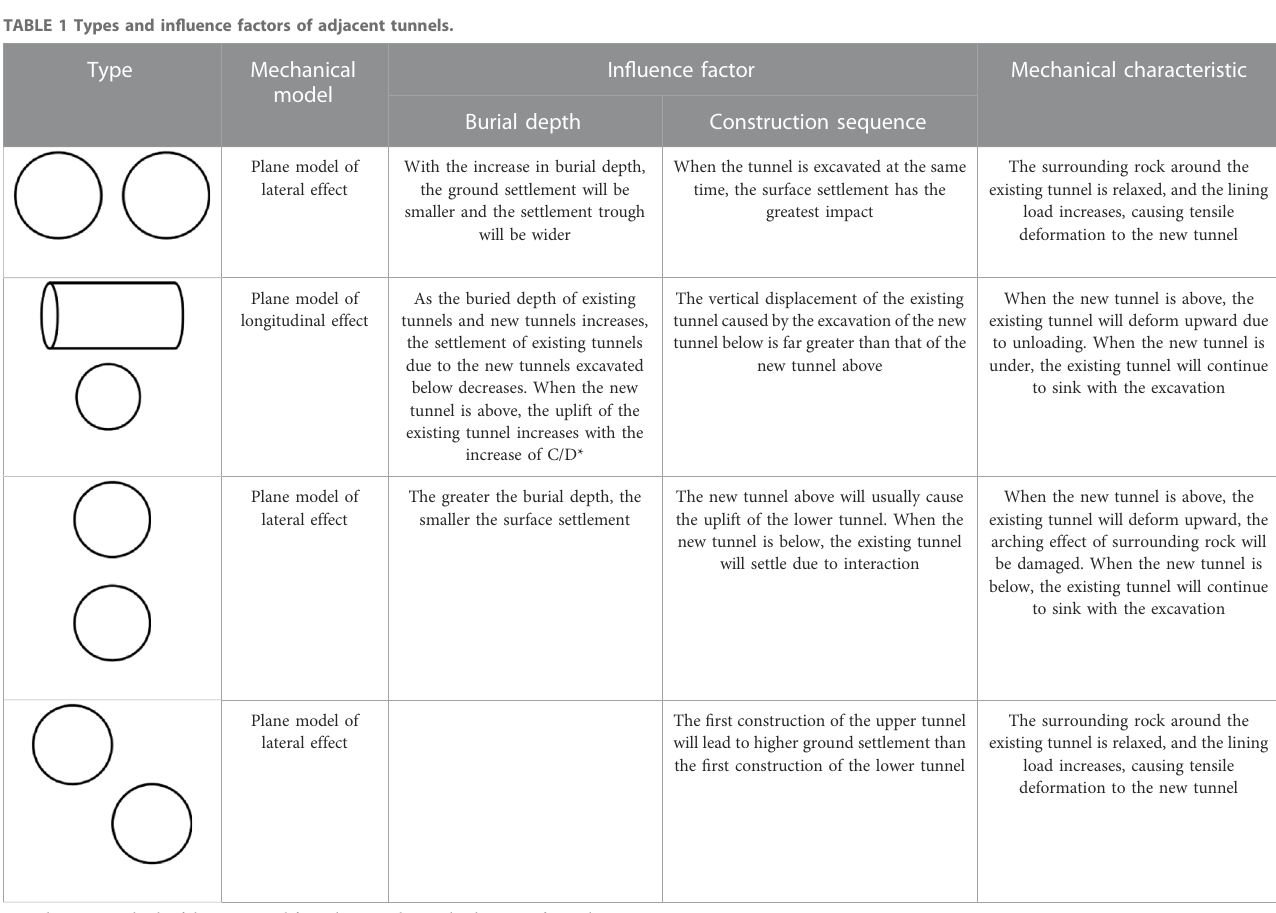
Table 1 that the construction types of adjacent tunnels can be divided into four categories: parallel, intersection, overlapping, and interlacing.